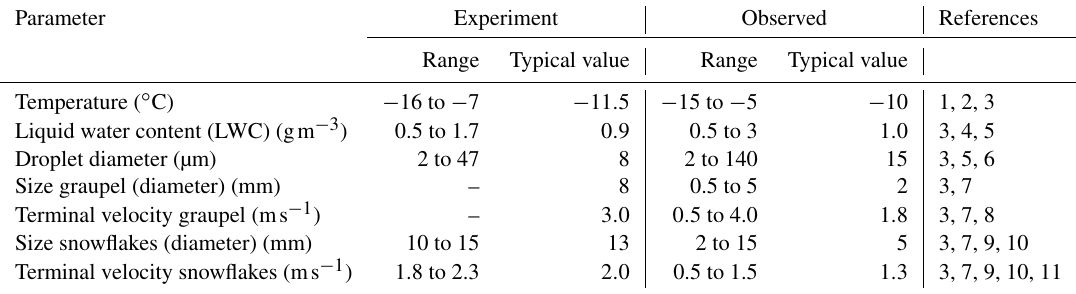
Table 1. Comparison between the experimental parameters and the ones observed in the real atmosphere. Parameter ranges and typical values (not necessarily mean values) are also given.